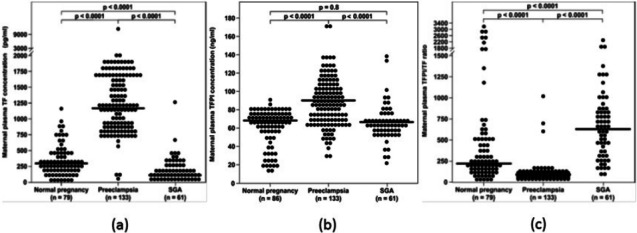
(A) Comparison of median maternal plasma TF concentration between patients with normal pregnancy (n = 79), pre-eclampsia (n = 133), and women who delivered an SGAneonate (n = 61). (B) Comparison of median maternal plasma TFPI concentration between patients with normal pregnancy (n = 86), pre-eclampsia (n = 133), and women who delivered an SGA neonate (n = 61). (C) Comparison of maternal plasma TFPI/TF ratio between women with normal pregnancy (n = 79), pre-eclampsia (n = 133), and women who delivered an SGA neonate (n = 61). From Erez et al. (2008).